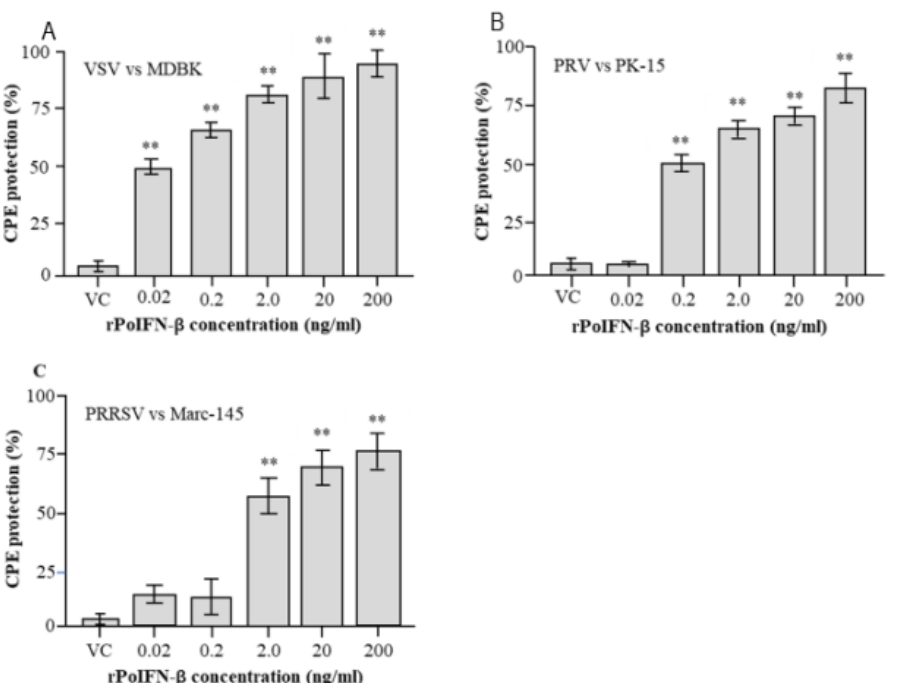
Figure 5. Detection of pre-infection antiviral activities of rPoIFN- β . Three cell lines ( A – C ) were treated with the indicated concentrations of rPoIFN- β for 24 h and then infected with the three pig viruses. The pre-infection antiviral activities were measured in triplicates by CPE inhibition assay. ** indicates significant difference ( p < 0.01) in CPE protection of rPoIFN- β as compared with the virus control